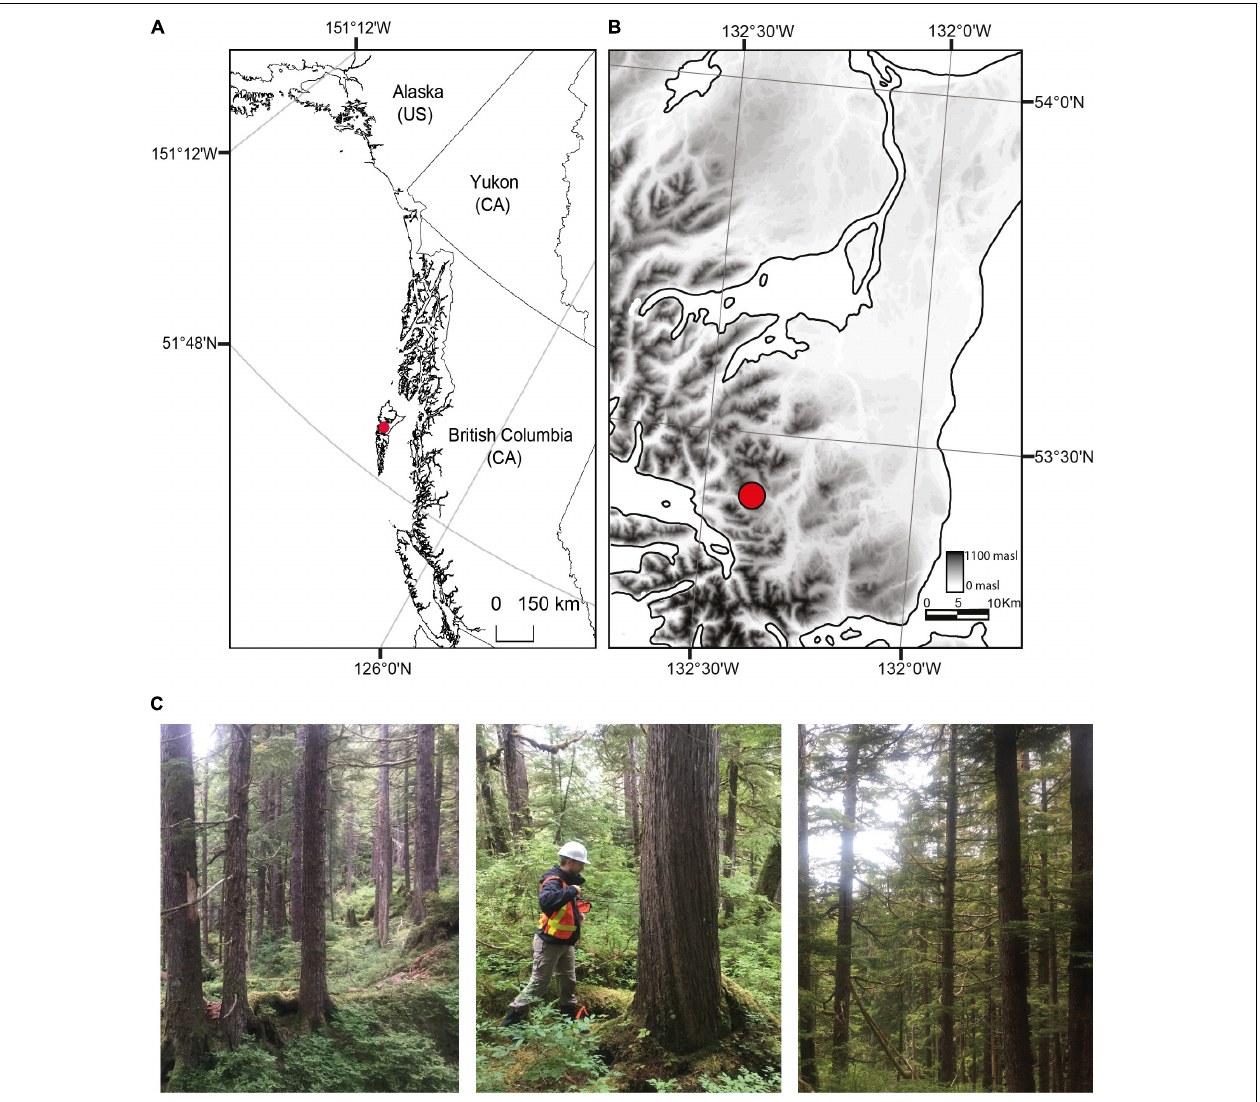
FIGURE 1 | Location of the study site on Haida Gwaii, British Columbia, Canada (red circle in A,B ). The old-growth forest was comprised of Sitka spruce, western hemlock, and yellow-cedar trees that were up to 130 cm in diameter at breast height and 770 years old (C) . (Photos by V. Comeau).